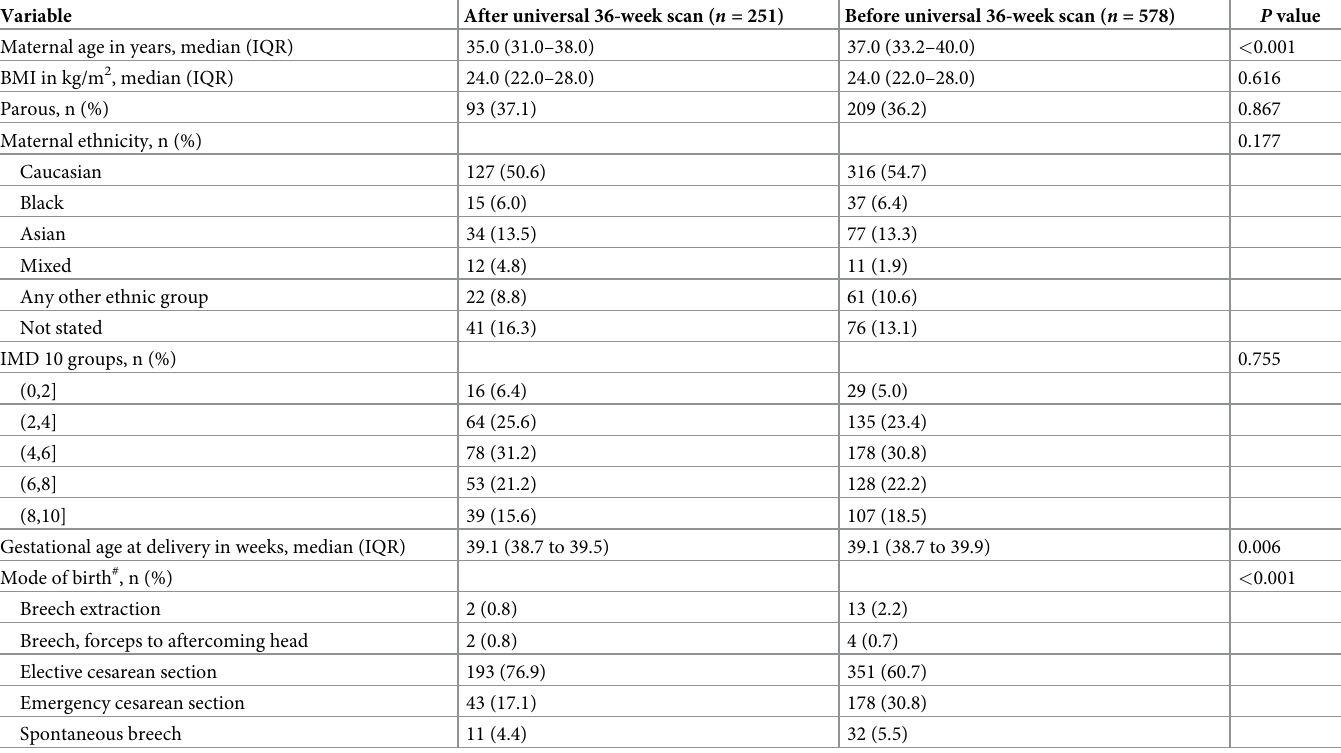
Table 2. Baseline characteristics of pregnancies with breech presentation at birth in the study epochs before and after the introduction of universal 36-week ultra- sound scan.